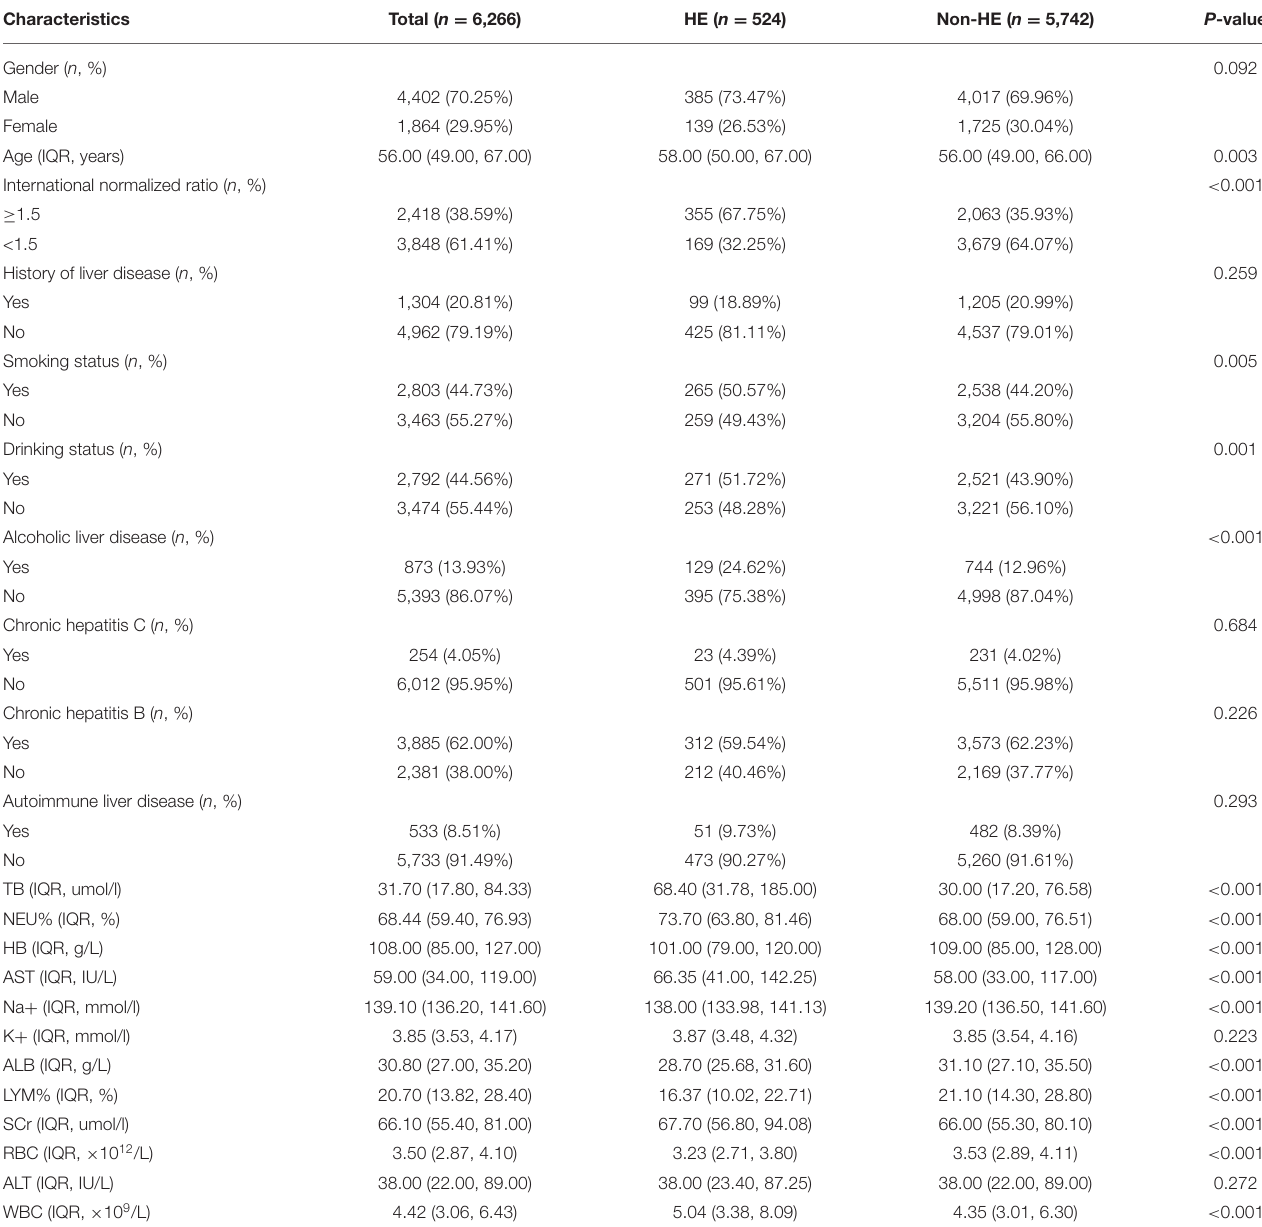
TABLE 1 | Demographic and clinical characteristics of the study population. Characteristics